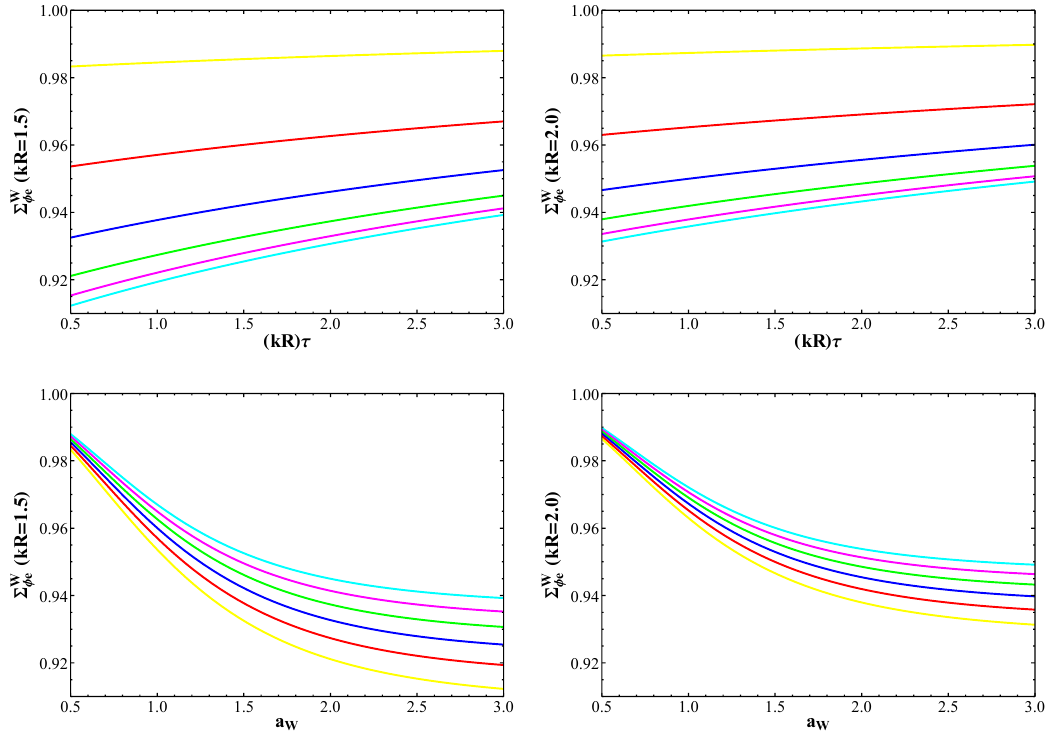
Figure 17 . (Top left) The sum Σ W defined in eq. (4.11), which encapsulates the dependence of the φe DM-electron scattering cross section on parameters of the model of the extra dimension, assuming kR = 1 . 5 , as a function of ( kR ) τ for a W = 3 (cyan), 5/2 (magenta), 2 (green), 3/2 (blue), 1 (red), and 1/2 (yellow), respectively. (Top right) As in the top left, but now assuming kR = 2 . 0 . (Bottom left) As in the top left, but now as a function of a W assuming ( kR ) τ = 3 (cyan), 5/2 (magenta), 2 (green), 3/2 (blue), 1 (red), and 1/2 (yellow), respectively. (Bottom right) As in the bottom left, but assuming kR = 2 . 0